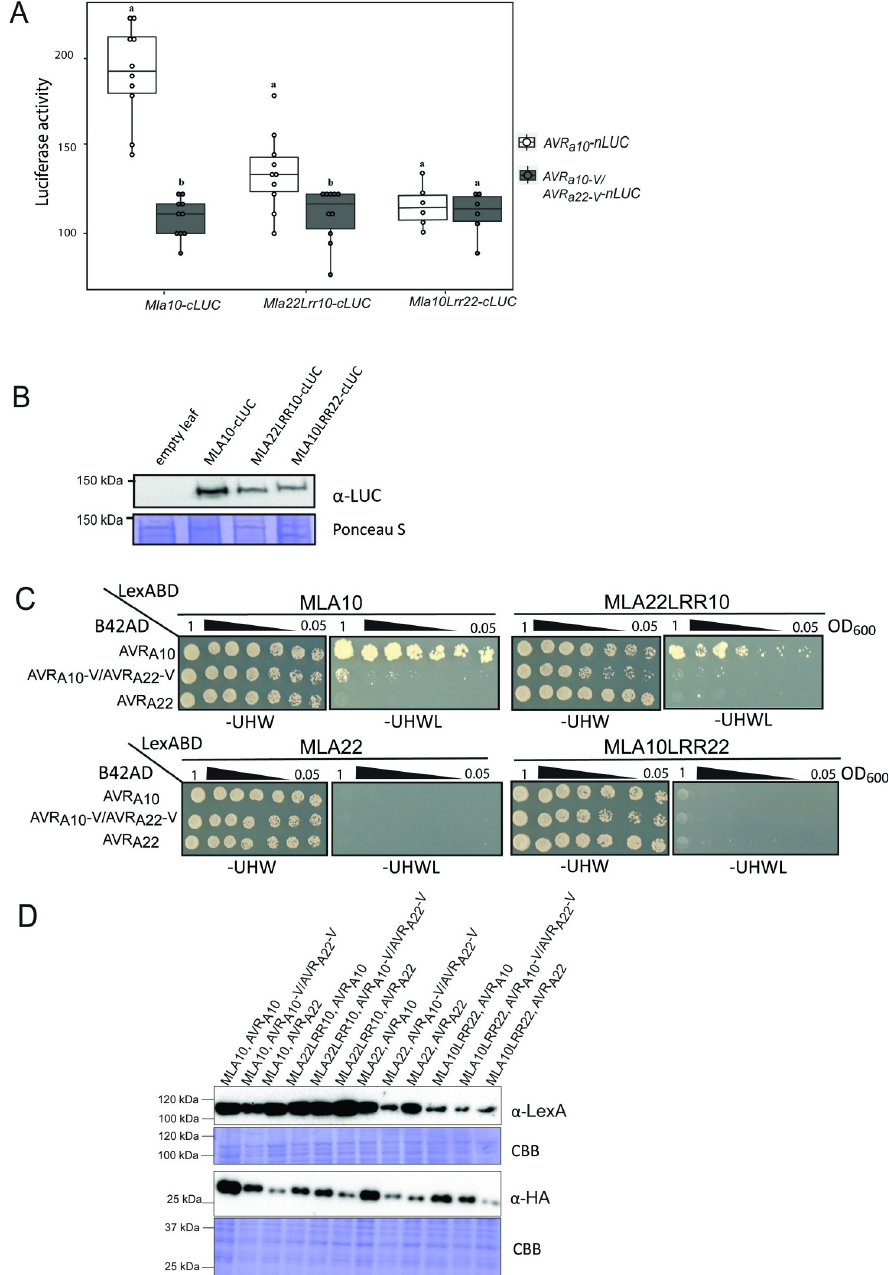
Fig 7. The LRR domain of MLA10 accounts for the specific interaction with AVR A10 in planta and in yeast. (A) Nicotiana benthamiana leaves were transformed transiently with vectors containing cDNAs of Mla10-cLUC , Mla10Lrr22-cLUC or Mla22Lrr10-cLUC together with vectors containing cDNAs of AVR a10 - nLUC or AVR a10 -V/ AVR a22 -V nLUC lacking signal peptides (SPs), under the control of a 35S promoter. LUC activity was determined forty hours after transfection. The experiment was performed on at least three independent days with two to four replicates (independent set of plants) each day. Significant differences between AVR - nLUC or AVR a10 a10 -V/ AVR a22 -V nLUC were analyzed using one-way Kruskal-Wallis (KW) analysis. Calculated KW p -values are as follows: Mla10: p = 0.0001491; Mla22Lrr10: p = 0.009035; Mla10Lrr22: p = 0.8079. Samples labeled with different letters differed significantly (p < 0.05). (B) Protein levels of MLA10-cLUC, MLA22LRR10-cLUC and MLA10LRR22-cLUC in N . benthamiana leaf extracts. Proteins were separated on a 8% SDS-PAGE gel and a detected using anti-LUC western blot (WB). (C) Yeast was co-transformed with cDNAs of N-terminal LexABD-fused MLA and N-terminal B42AD-fused AVR A variants. Growth on media lacking Leucine indicates association of respective proteins fused to AD (activation